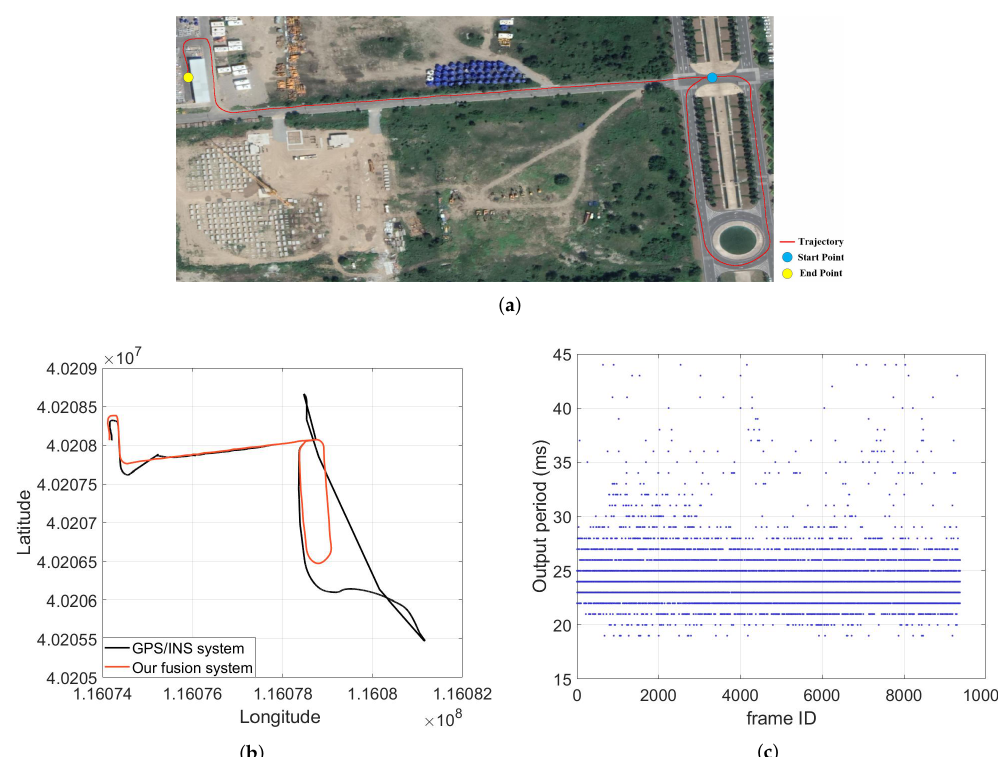
Figure 13. The results in a GNSS-deniedenvironment. ( a ) shows the trajectory generated by our system when the UGV drives at a speed around 20 km/h and the overall distance is about 1.3 km. ( b ) compares the trajectories generated by our system and by the disturbed GNSS/INS system. ( c ) shows the output period of our localization system during the whole process, and the average output frequency is about 39.7